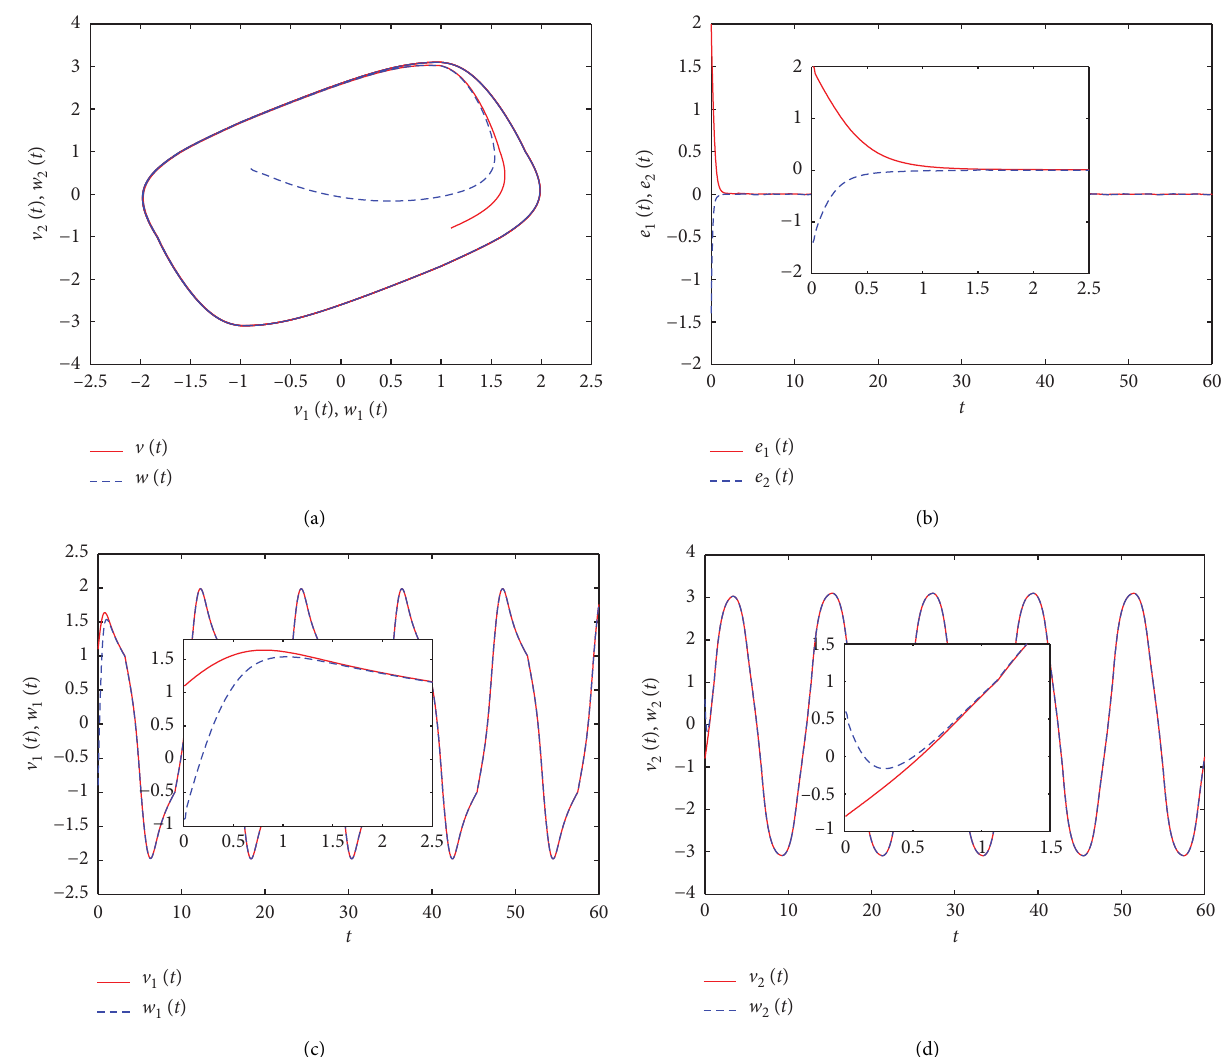
Figure 2: The chaotic behaviors, error and state trajectories of the derive FOMNN (46), and the response FOMNN (8) with the state feedback controller u